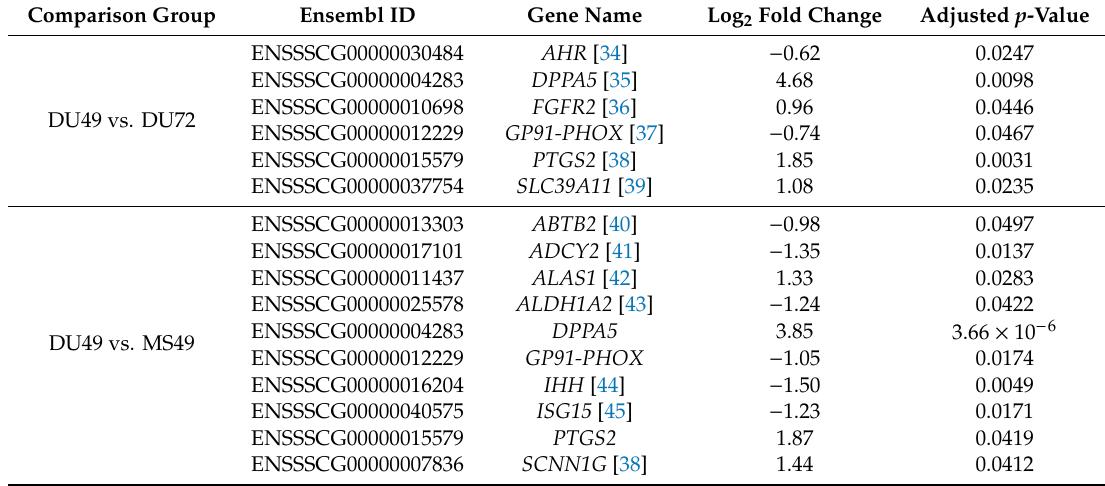
Table 2. Di ff erentially expressed genes associated with fetal loss or litter size based on previous